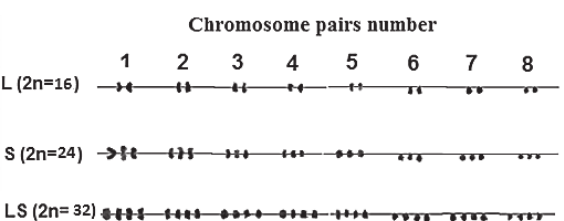
Fig. 3. Karyotypes of C. bursa-pastoris genotytpes. L: Lobed dip- loid (2n=2x=16); S: Simple triploid (2n=3x=24); LS: Lobed-Simple tetraploid (2n=4x=32).